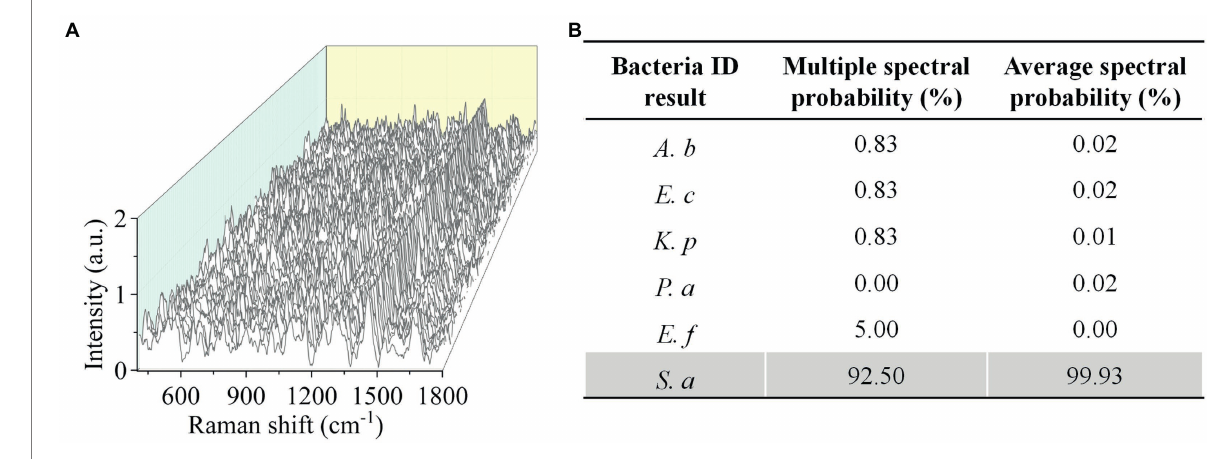
FIGURE 5 Rapid identification of S. aureus in urine by CRM. (A) Raman spectra of S. aureus . (B) Identification results by the deep learning model. A. baumannii ( A. b ) , E. coli ( E. c ) , E. faecium ( E. f ), K. pneumoniae ( K. p ), P. aeruginosa ( P. a ), and S. aureus ( S. a